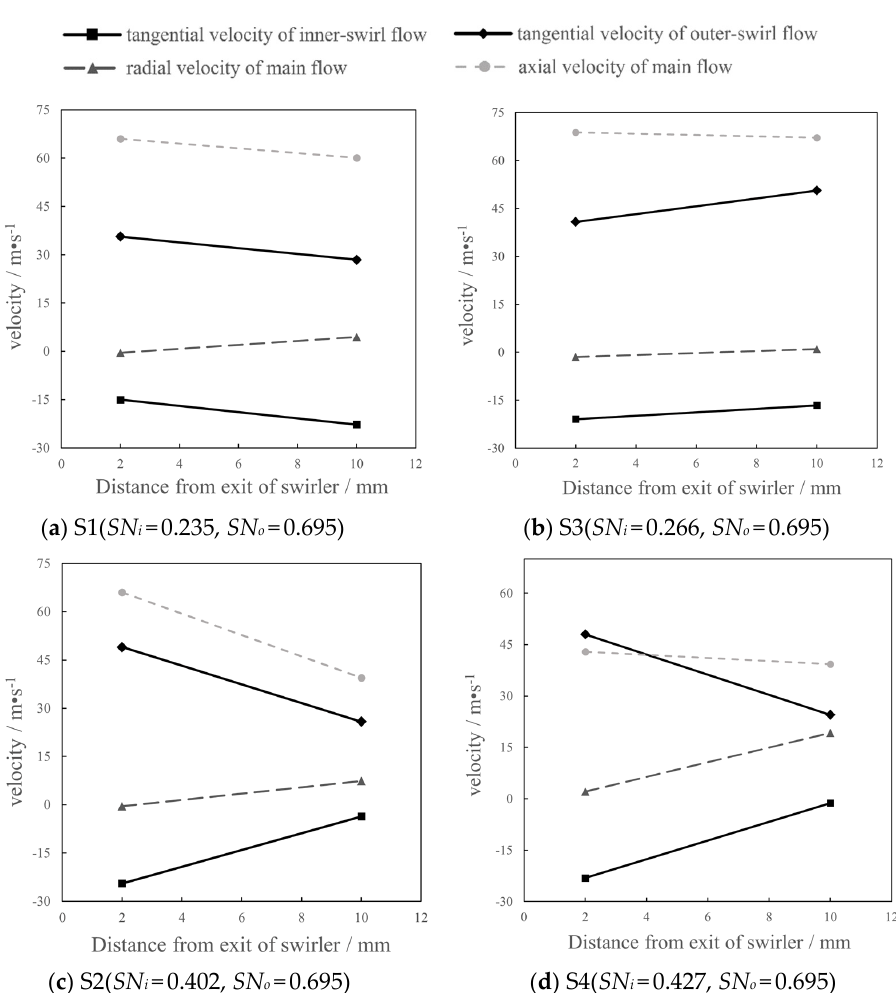
Figure 10. Summary of the development of each velocity component near the swirler exit.